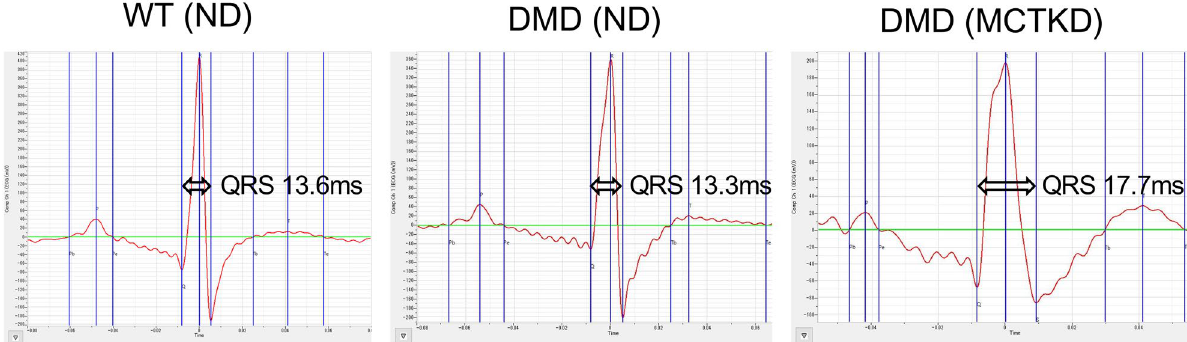
Figure 1. Representative electrocardiogram images. A significant prolongation of QRS duration was observed in MCTKD-fed DMD rats. DMD = Duchenne muscular dystrophy, MCTKD = medium-chain triglycerides containing ketogenic diet, ND = normal diet, WT = wild type.